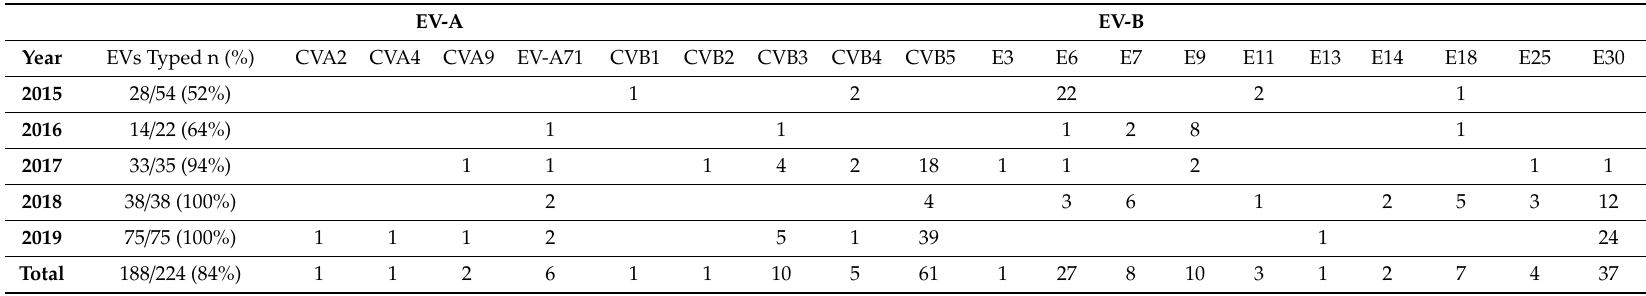
Table 1. Enterovirus types identified between 2015 and 2019 in children with infection of the CNS attributed to enteroviruses in Bialystok, Poland divided by